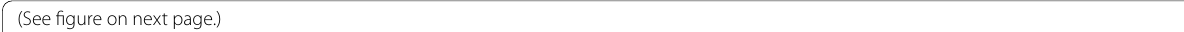
tional file 1: Table S7). Six microbes were identified as clear driver nodes due to their altered associations